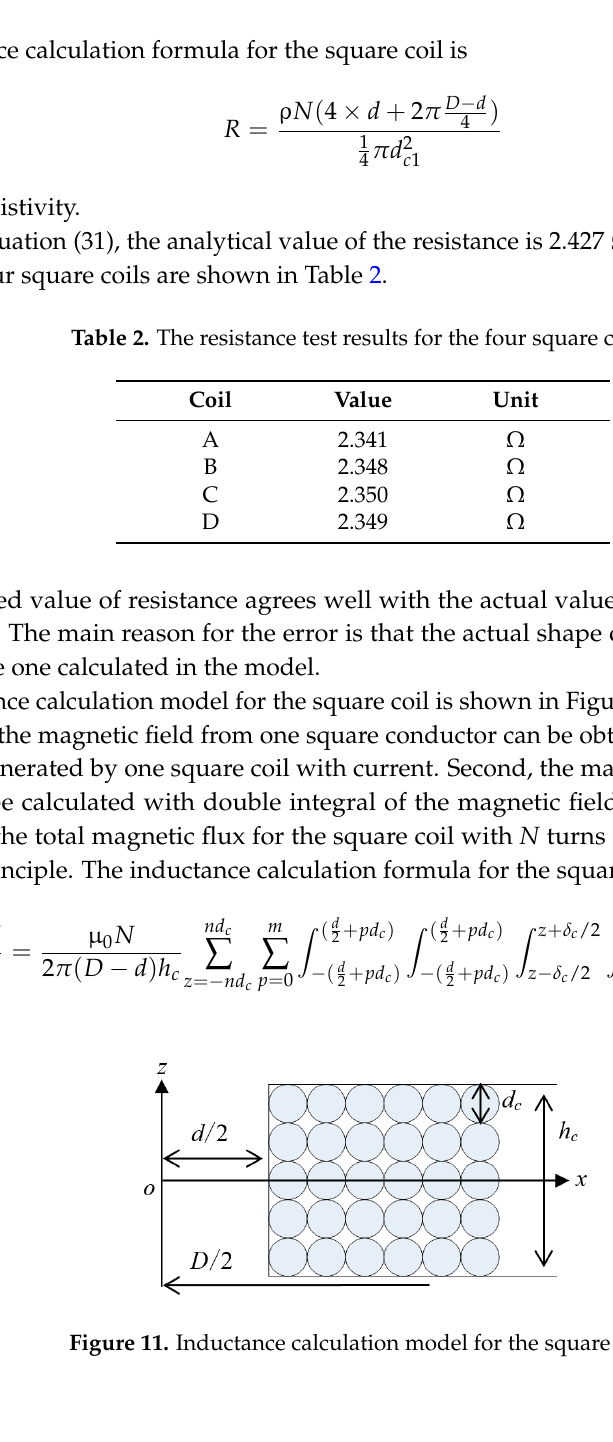
Table 3. The inductance test results for the four square coils.